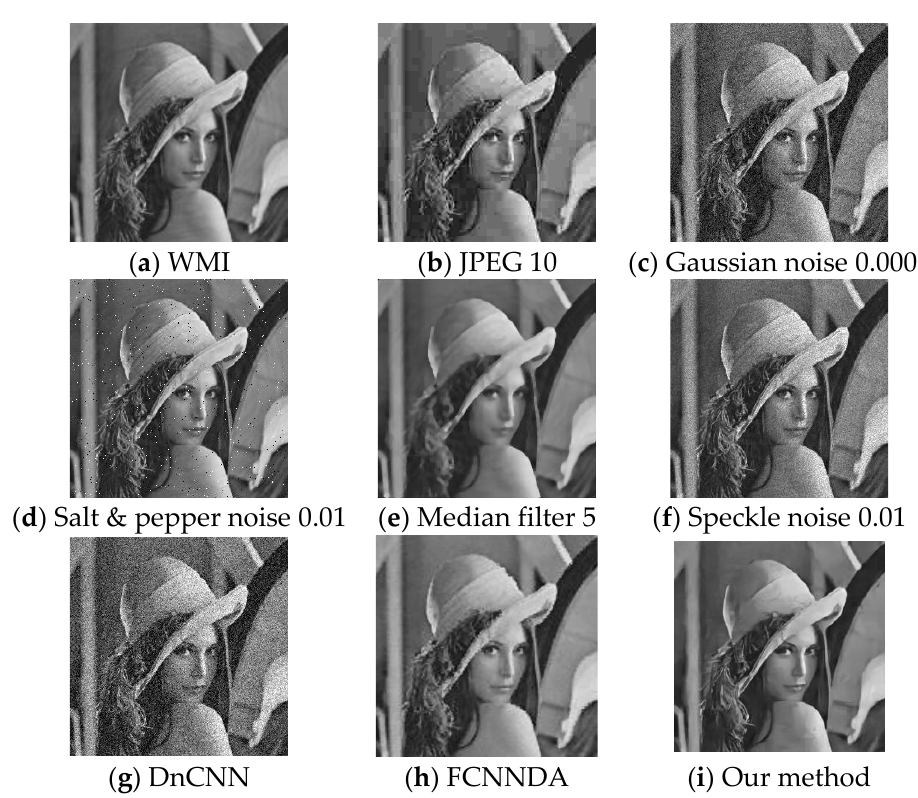
Figure 3. Comparison of AWMIs after applying different attacks to WMIs; the watermark size is 16 × 16.